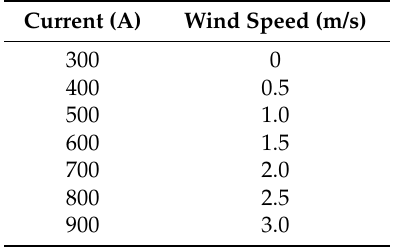
Table 1. Test group parameters (7 × 7 = 49 groups).